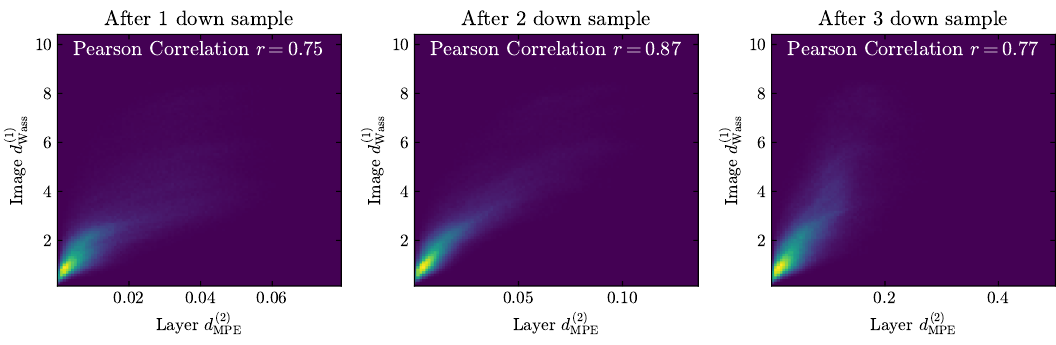
Figure 5 . Correlations of the pair-wise event distance in the image space with the interior activa- tions of the network after different numbers of downsampling blocks.